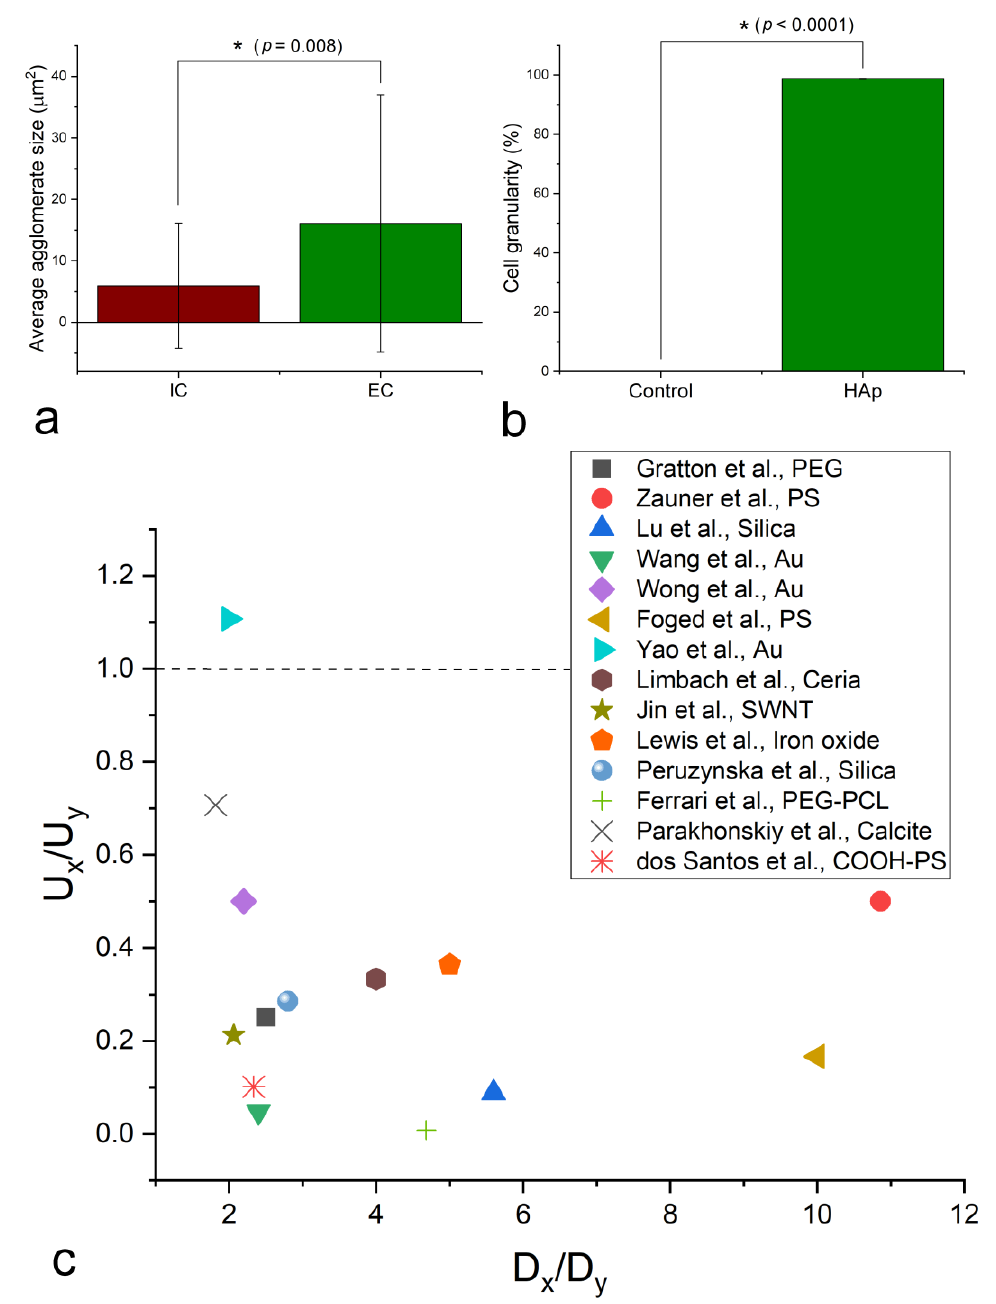
Figure 5. The significantly lower average size of the surface projection of optically imaged intracellular (IC) HAp nanoparticle agglomerates in interaction with hMSCs (n = 40) compared to that of the extracellular (EC) nanoparticle agglomerates ( a ). Granularity of hMSCs challenged with HAp nanoparticles approaching 100%, showing that practically all cells uptake the nanoparticles (n = 3) ( b ). Meta-analysis of literature data representing the ratio between the uptaken concentration of larger particles and the uptaken concentration of smaller particles (U x / U y ), as a function of the ratio between the size of the larger particles and the size of the smaller particles (D x / D y ) in various cell types, excluding macrophages ( c ) . Physical qualities measured to assess the difference in the uptake efficiency between differently sized particles varied between studies and included percent internalization (Gratton et al. [60]), weight of the exogenous ion determined by ICP-MS per cell (Lu et al. [61], Wong et al. [62], Yao et al. [63], Limbach et al. [64], Lewis et al. [65]), the number of nanoparticles per cell derived from plasmonic scattering (Wang et al. [66]), uptake rate via flow cytometry (Foged et al. [67], Zauner et al. [68] Peruzynska et al. [69], Ferrari et al. [70], dos Santos et